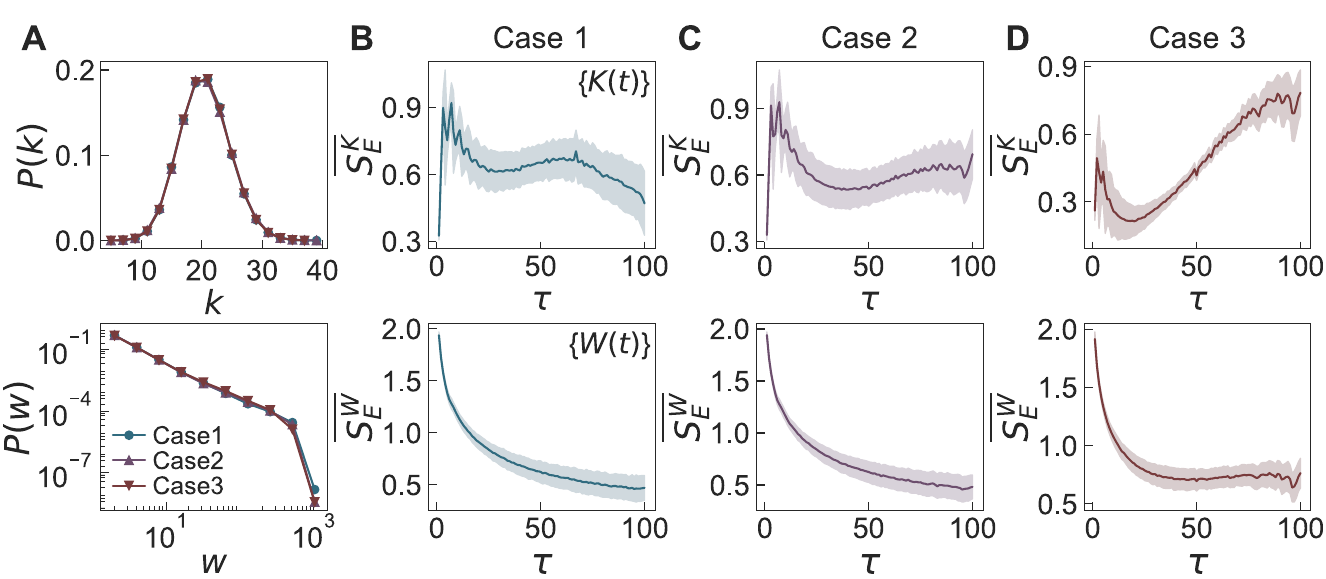
Fig 8. Simulation results of the temporal network model. (A) Degree and weight distributions of time-aggregated networks and (B–D) the results by the MSE method applied to { K ( t )} (top panels) and { W ( t )} (bottom panels), denoted as S K and S W , respectively. For each combination of parameter values ( t h , λ K ,h / λ K ,l , λ L ,h / λ L ,l ) E E = (200, 3, 1) (“Case 1”), (100, 3, 1) (“Case 2”), and (100, 9, 1.5) (“Case 3”), we generate 10 3 temporal networks using the fixed values of N = 100, K = 1000, W = 10000, T = 2000, ρ K = 0.2, ρ L = 0.8, and n = 5. In panel (A), degree distributions P ( k ) are linearly binned, while weight distributions P ( w ) are logarithmically binned.